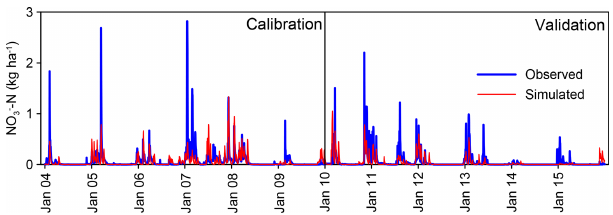
Figure 6. Boxplots of measured (obs.) and simulated (sim.) crop Figure 4. Observed and simulated NO − -N loadings at a daily time 3 yields for winter wheat, winter barley, rapeseed, and maize silage scale during the calibration and validation period. covering the entire simulation period